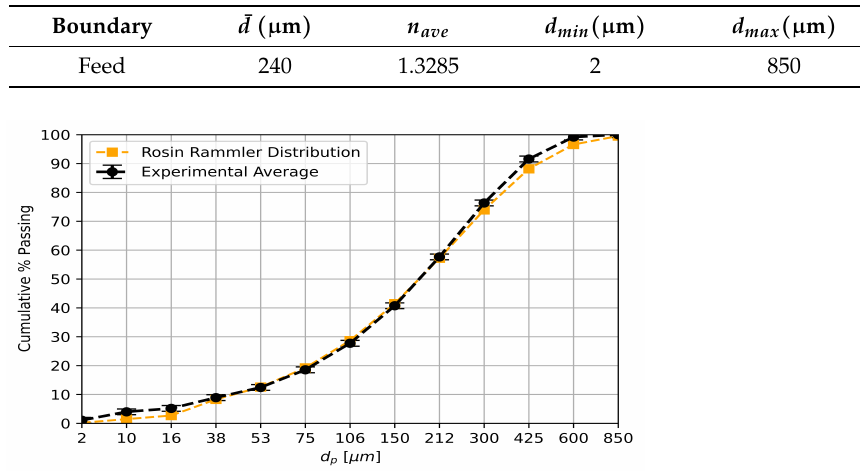
Table 4. Rosin–Rammler Distribution Parameters.